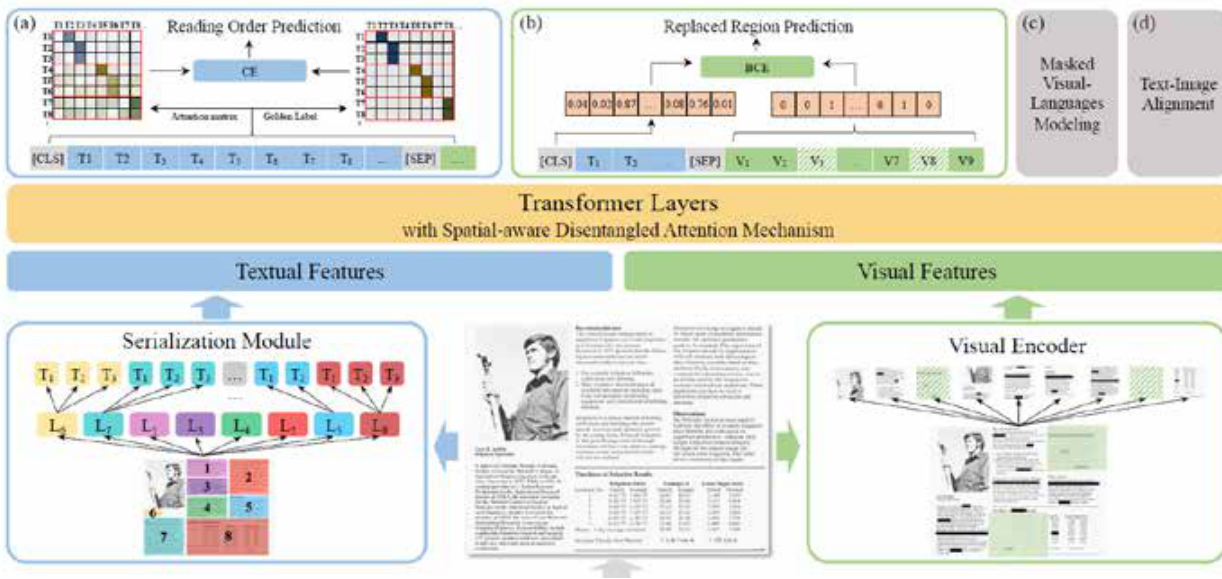
Figure 6 The architecture and training method of ERNIE-Layout [23]. HelixGEM For the medical field, in 2022, Baidu launched biological computing large models, including HelixGEM2.0 [25] (compound characterization), HelixFold [26] (protein structure prediction), HelixFold- Single [27] (single-sequence protein structure